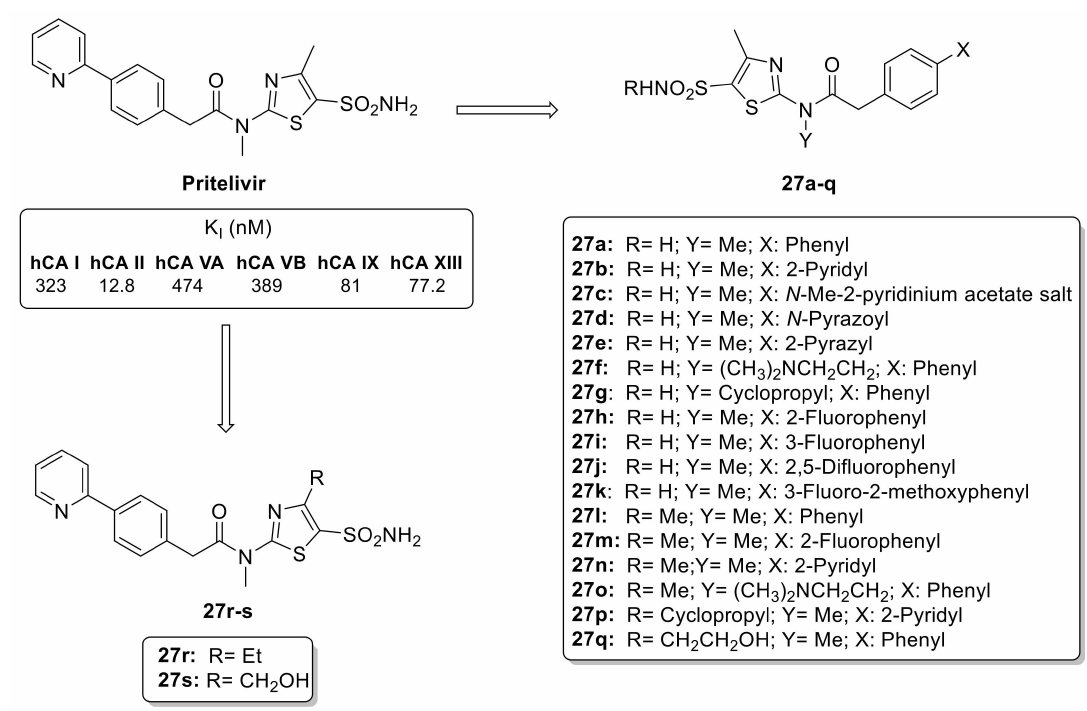
Figure 5. Structure of pritelivir and its derivatives 27a – s